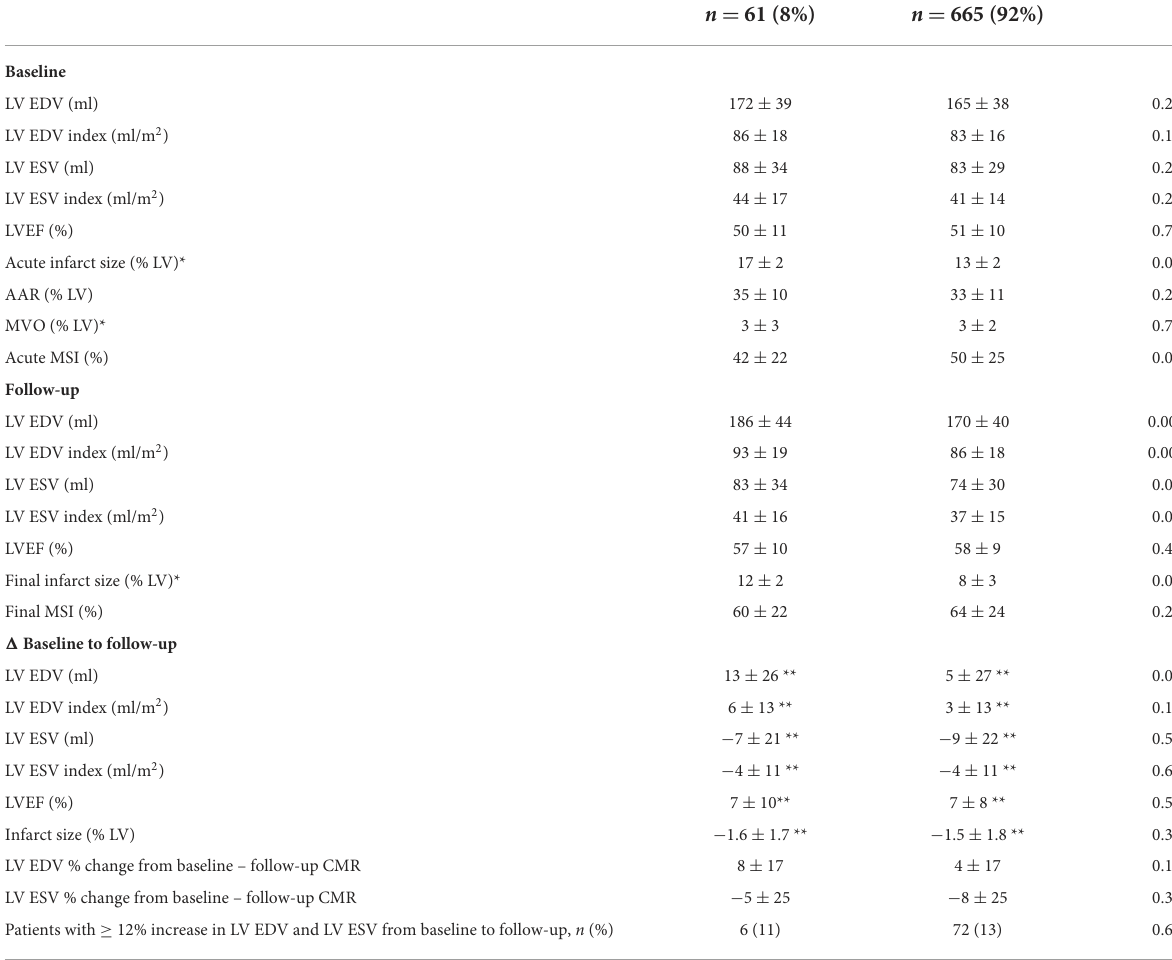
TABLE 3 CMR variables at baseline and